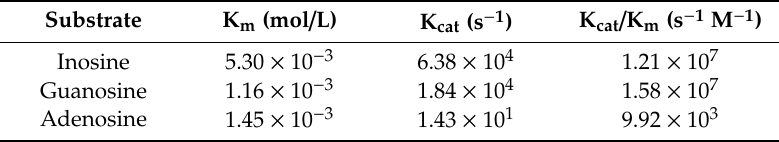
Table 2. Kinetic parameters for Am PNP with various purine nucleosides.